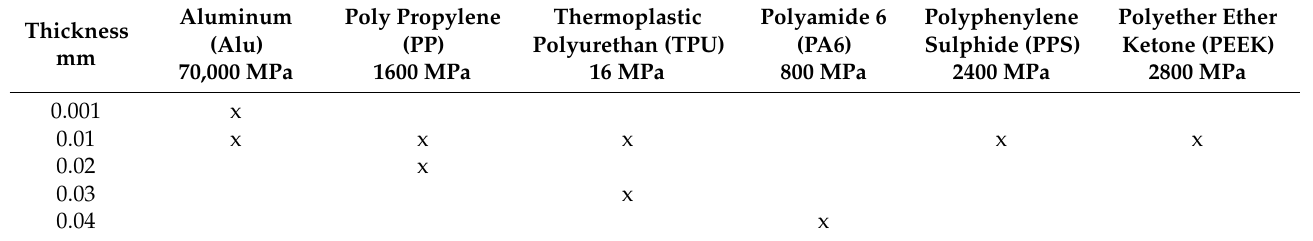
Table 1. Measured film materials with their Young’s modulus and thicknesses.